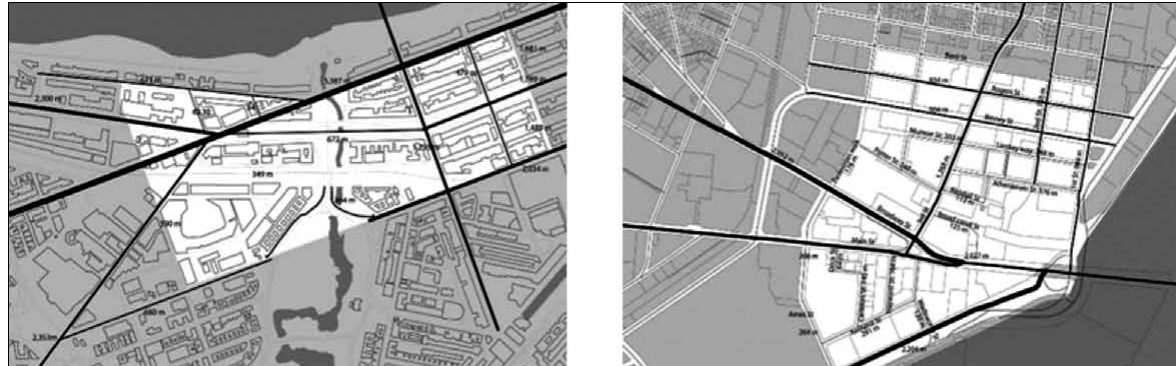
fig. 2. objective measurement of continuity. left: Kenmore and West Back Bay / right: Kendall